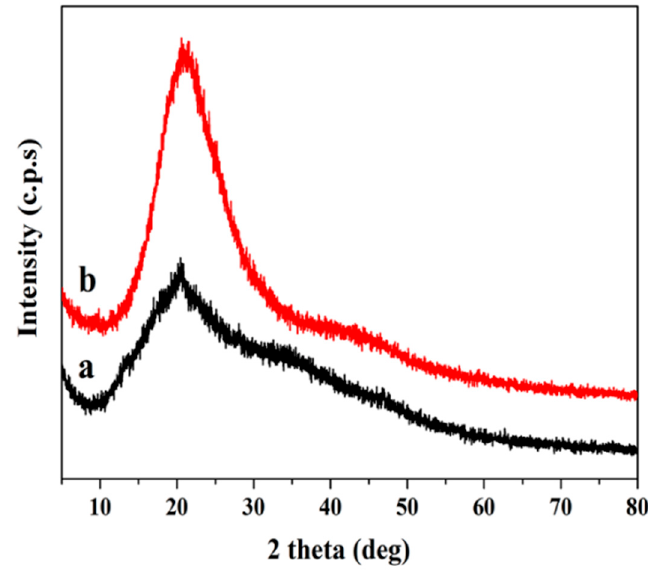
Figure 2. The X-ray diffraction of ( a ) SF and ( b ) FPU coating.